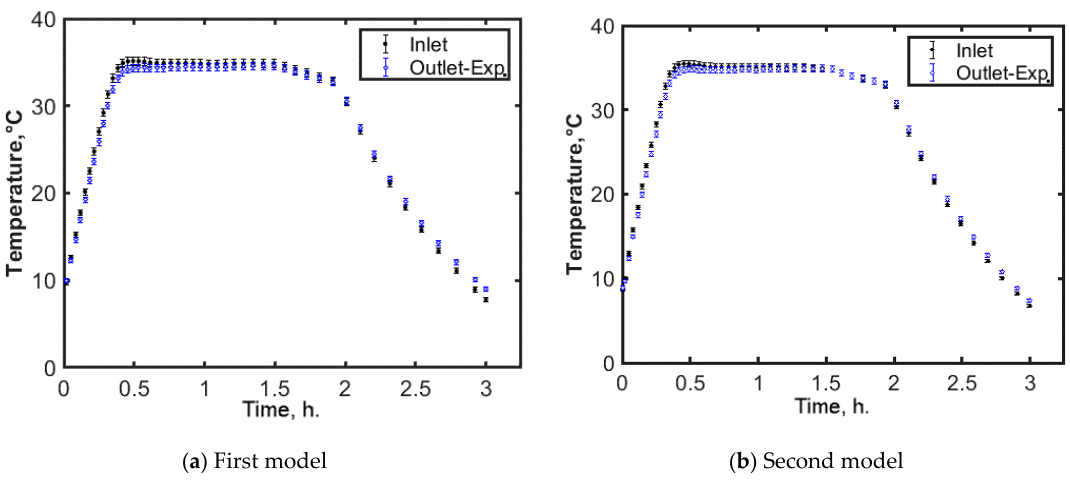
Figure 10. Experiment inlet temperature and outlet temperature profiles at Q = 1471 mL/min.